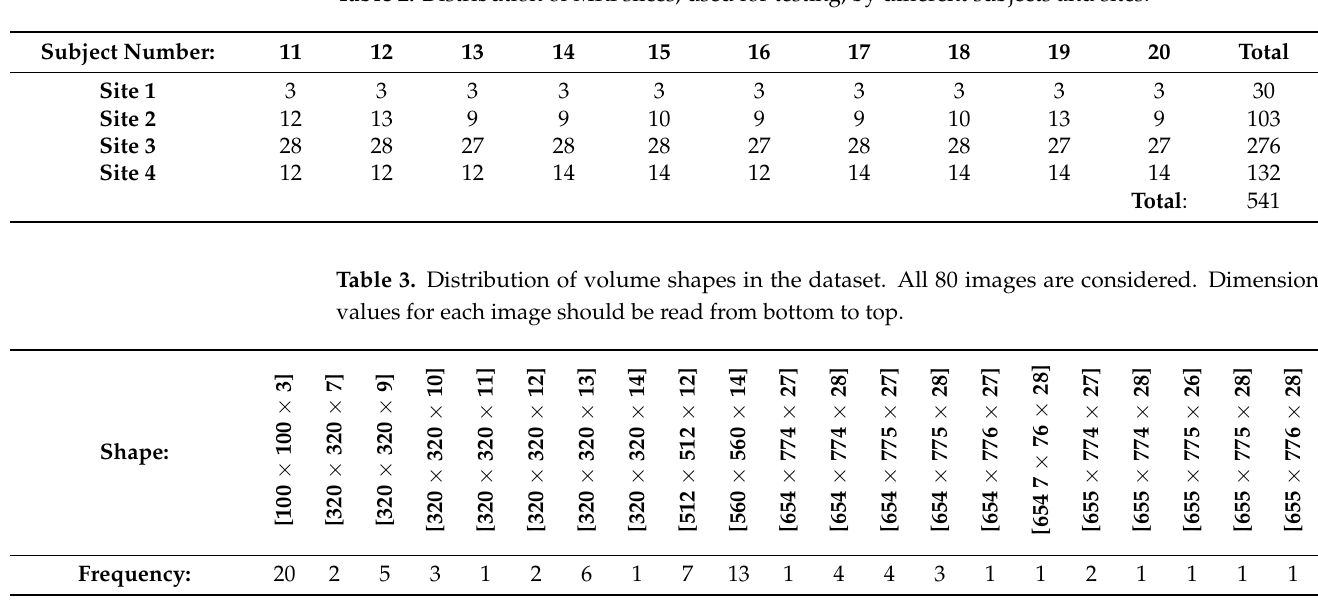
Table 2. Distribution of MRI slices, used for testing, by different subjects and sites.